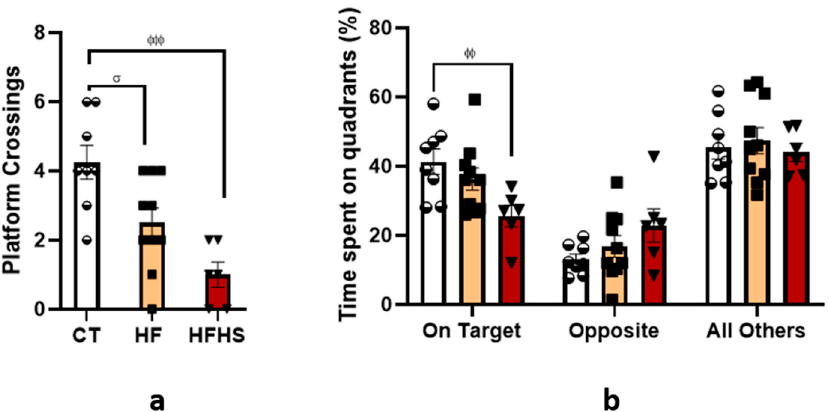
Figure 6. Histogram ( a ) shows the mean ± SEM number of platform crossings during the probe trial. HFHS rats crossed the former position of the platform less frequently than the control rats. The histogram in ( b ) shows the mean ± SEM values of the percentage of cumulative time spent throughout the test in the quadrant where the hidden platform was located compared to the opposite quadrant and all other quadrants. HFHS rats spent less time in the target quadrant than the control rats. φφ p < 0.01, φφφ p < 0.001 HFHS versus controls; σ p < 0.05 HF versus control. The bars in white represent the mean for the control group, the bars in orange represent the mean for the HF group, and the bars in red represent the mean for the HFHS group. The circle represents the value for each animal in the control group, the square represents the value for each animal in the HF group, and the inverted triangle represents the value for each animal in the HFHS group.